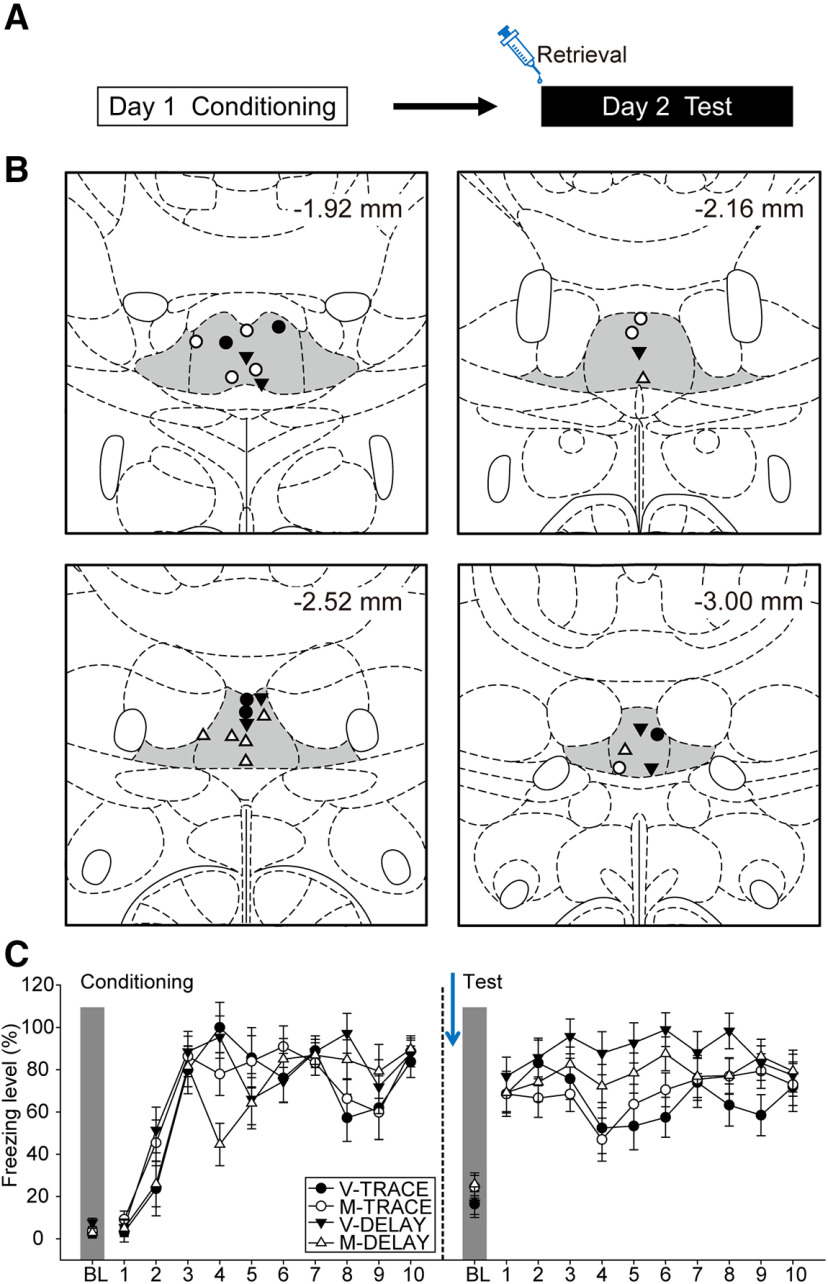
The ReRh was not involved during the retrieval of trace fear conditioning. A, Experimental design. Animals underwent a 2-d behavioral experiment, in which the animals received drug infusion immediately before test (day 2). B, Injector tip placements of all the animals included in data analyses at levels −1.92, −2.16, −2.52, and −3.00 mm posterior relative to bregma. The gray areas marked in the atlas are the Re and ventral Re. C, The freezing behavior of V-TRACE (n = 5), M-TRACE (n = 7), V-DELAY (n = 7), and M-DELAY groups (n = 7) when injections were performed before retrieval test.